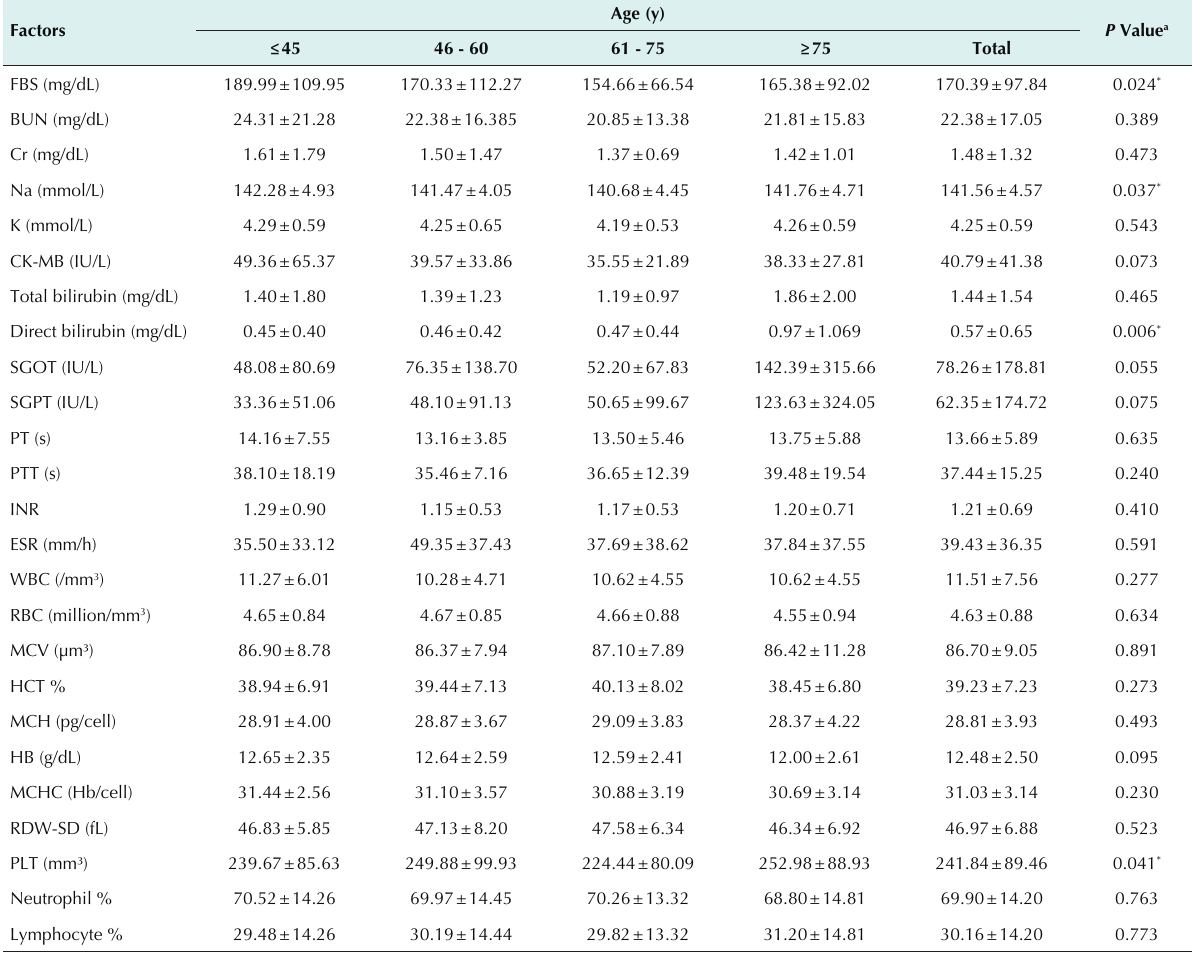
Table 4. Mean and Standard Deviation of Factors Studied in Patients With Cardiovascular Diseases by Age Groups